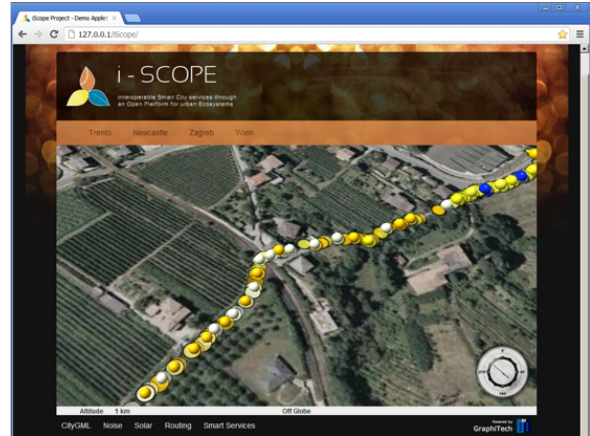
Figure 6 NoiseTube data acquired visualized into i-SCOPE web